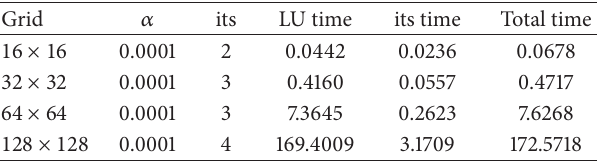
Table 9: Preconditioned GMRES(20) on Stokes problems with different grid sizes (uniform grids).